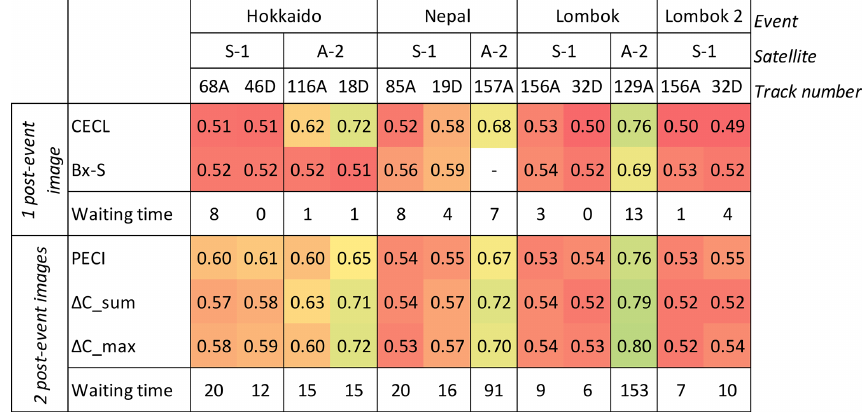
Figure 5. AUC values for each classifier described in Sect. 2 at a resolution of 20m × 22m. For Hokkaido, we use the inventory of Zhang et al. (2019). Insufficient pre-event data were available on A157a to calculate the Bx–S classification surface. Colours range from red (worst- performing AUC < 0.55) to green (best-performing, AUC >